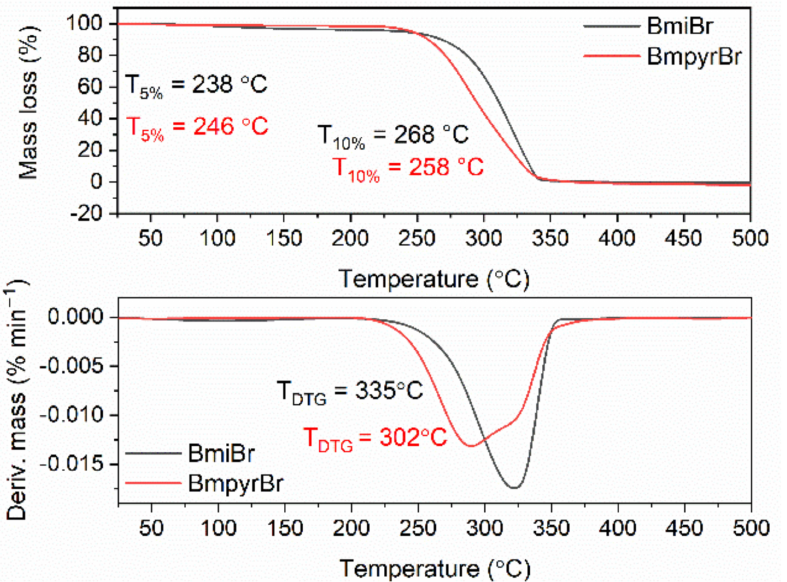
Figure 1. Thermogravimetric (TG) and derivative thermogravimetric (DTG) curves of BmiBr and BmpyrBr.